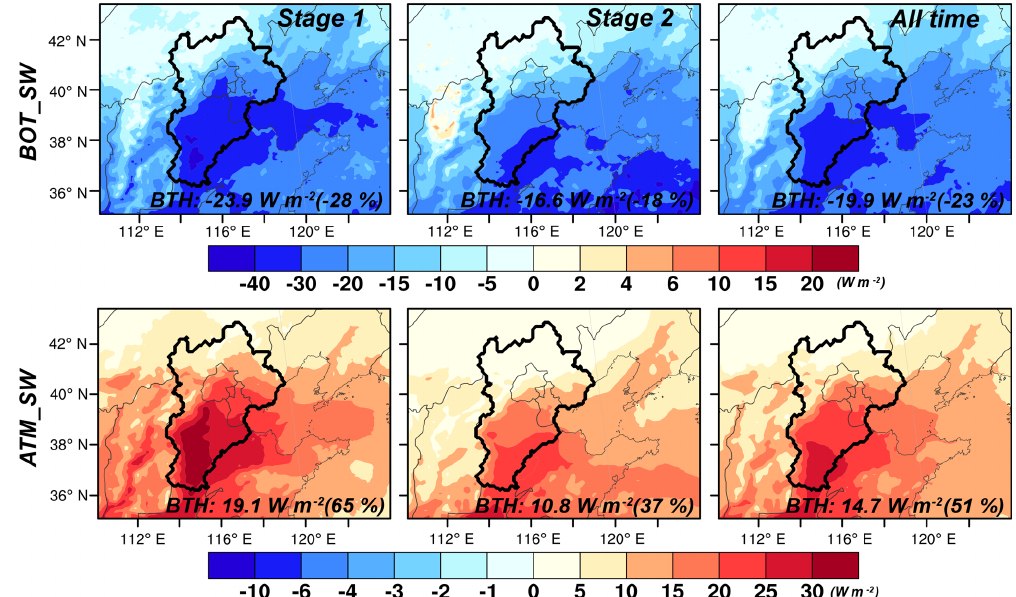
Figure 9. The differences in simulated all-sky radiative forcing (Wm − 2 ) between the CTL and NoARE cases (CTL minus NoARE) averaged over Stage 1, Stage 2, and the whole simulation period. “BOT_SW” and “ATM_SW” denote the downward shortwave radiative flux at the surface and in the atmosphere, respectively. The calculated differences in the simulated radiative forcing averaged over Beijing–Tianjin– Hebei for each stage are also shown at the bottom of each